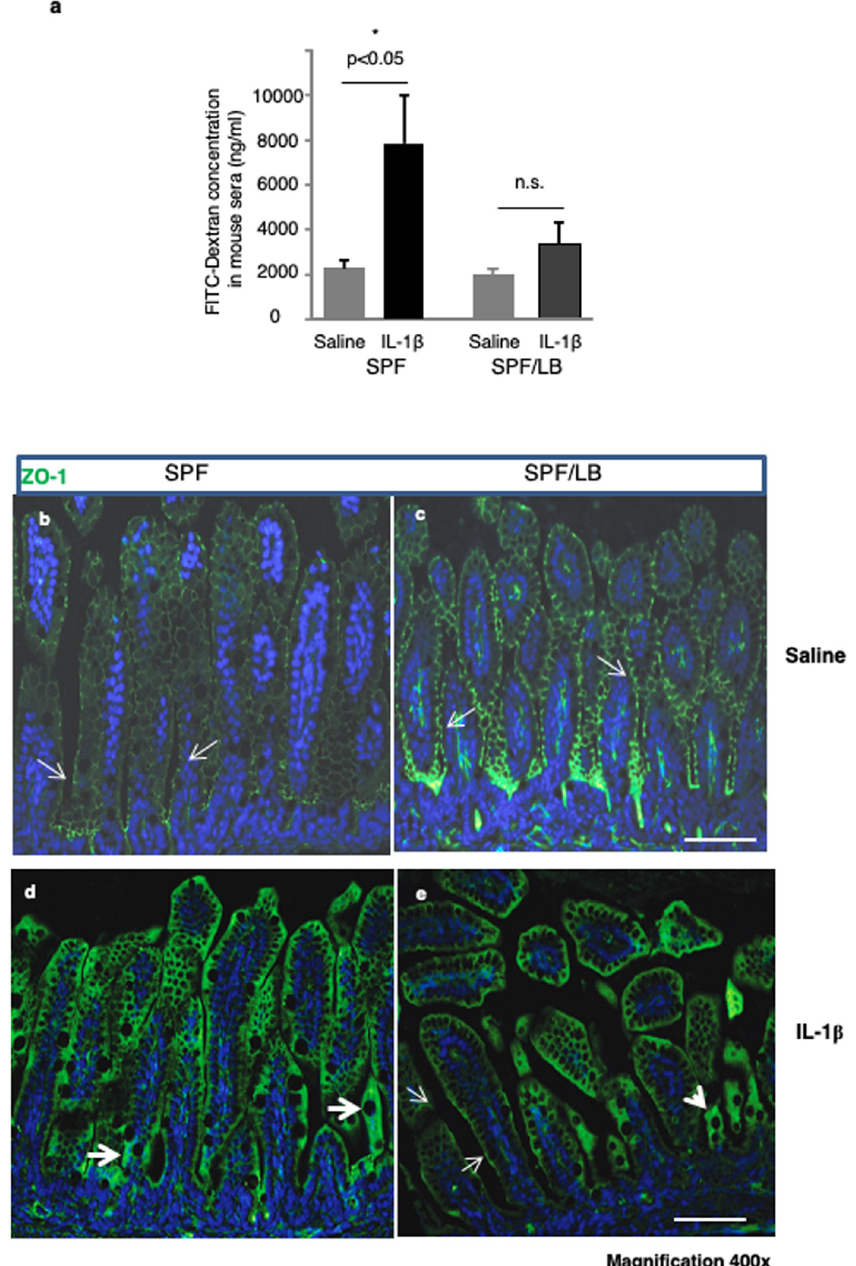
Fig 3. Maternal LB exposure rescued IL-1 β induced gut barrier dysfunction in preweaned pups. a) IL-1 β induced elevation of serum FITC-dextran translocation in SPF (n = 5) and SPF/LB (n = 6) was measured and presented as mean ± SEM. One-way ANOVA and Tukey’s post-hoc test was used and � p < 0.05. b) Immunofluorescence detection of ZO-1 molecules (green) in the SPF mouse ileum. c) Immunofluorescence detection of ZO-1 molecules (green) in the SPF/LB mouse ileum Representative areas (n = 3 per group) are shown Bar: 100 μ M, magnification 400x. d) IL-1 β stimulation induced disruption of tight junction (ZO-1) in SPF pups. e) LB protected tight junction integrity in SPF/ LB pups. Immunofluorescence detection of ZO-1 translocation is indicated by white block arrows. (n = 3 per group, magnification 400x).